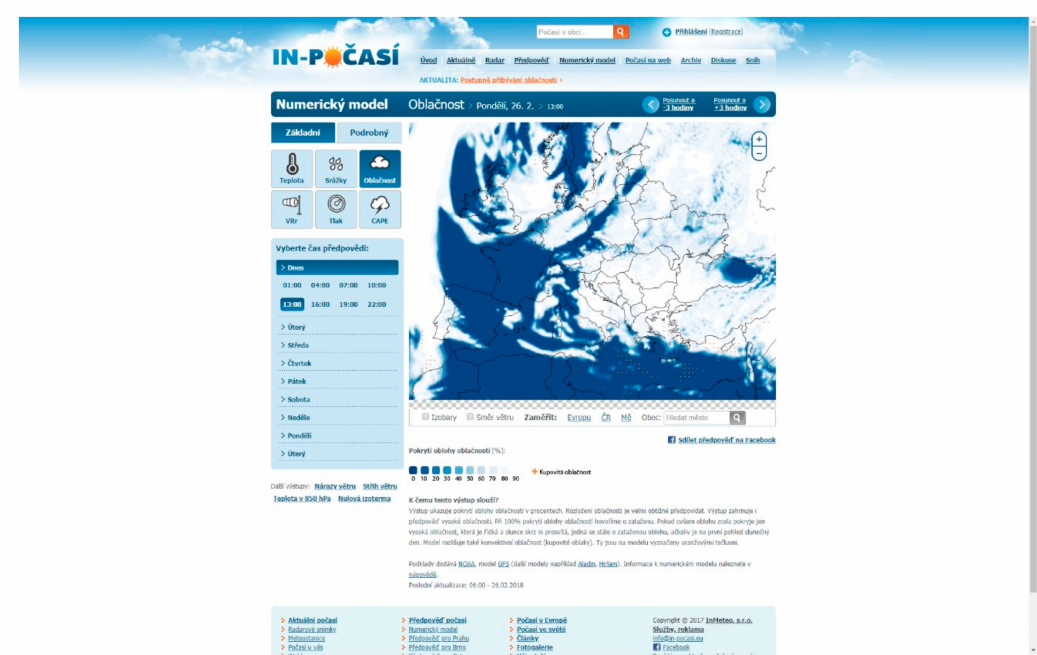
Figure 3. In-Poˇcas í map preview. The map is part of a web-page layout and has additional controls as web-page composition elements. The sample map presents the amount of cloud cover.